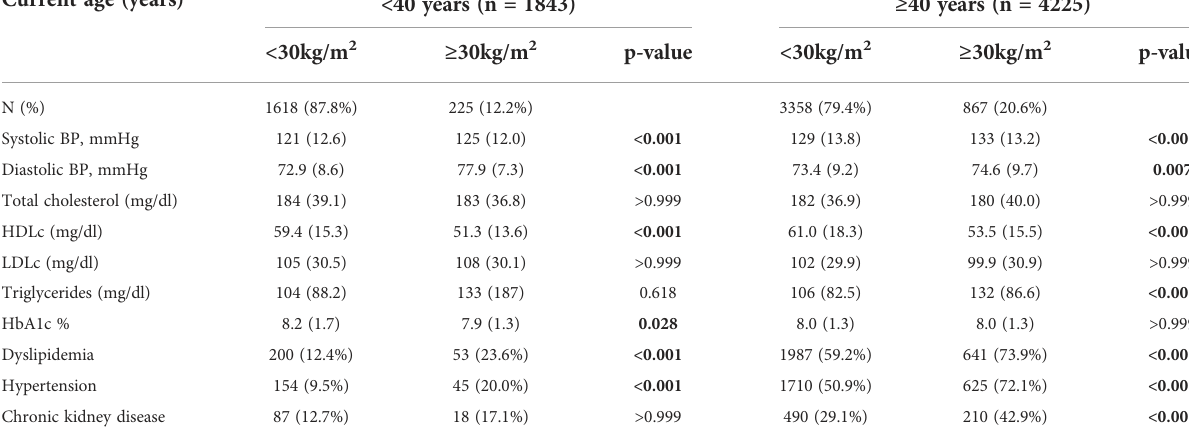
TABLE 3B Prevalence of obesity and clinical characteristics according to current age.